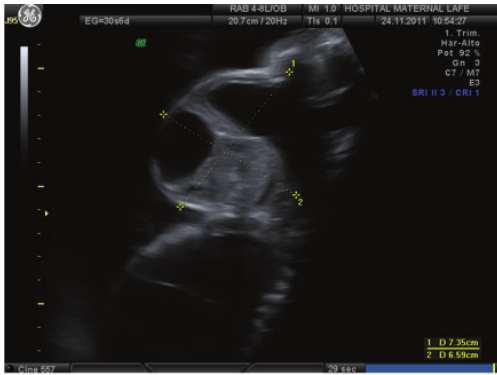
Figure 5: Lateral view of the last ultrasound control before surgery.